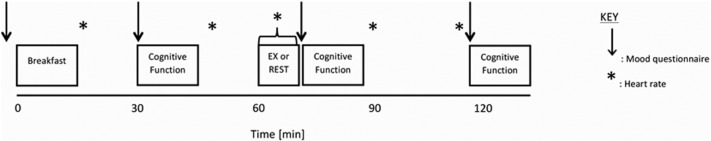
Experimental protocol.